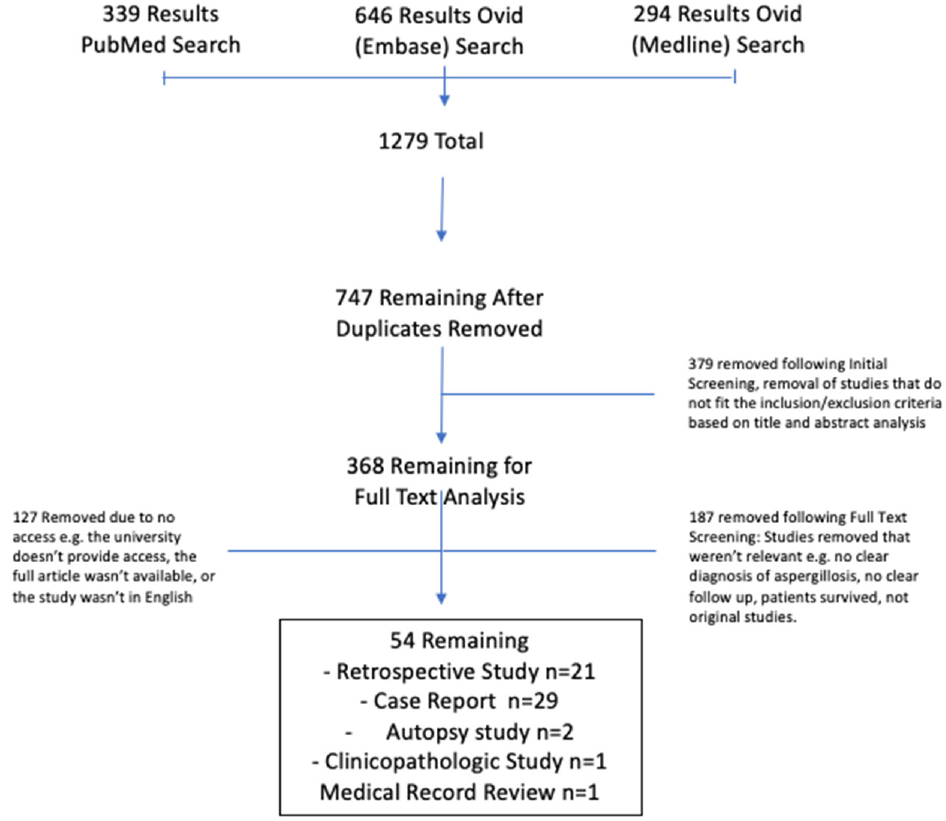
Figure 1. Flow chart indicated process of study selection .